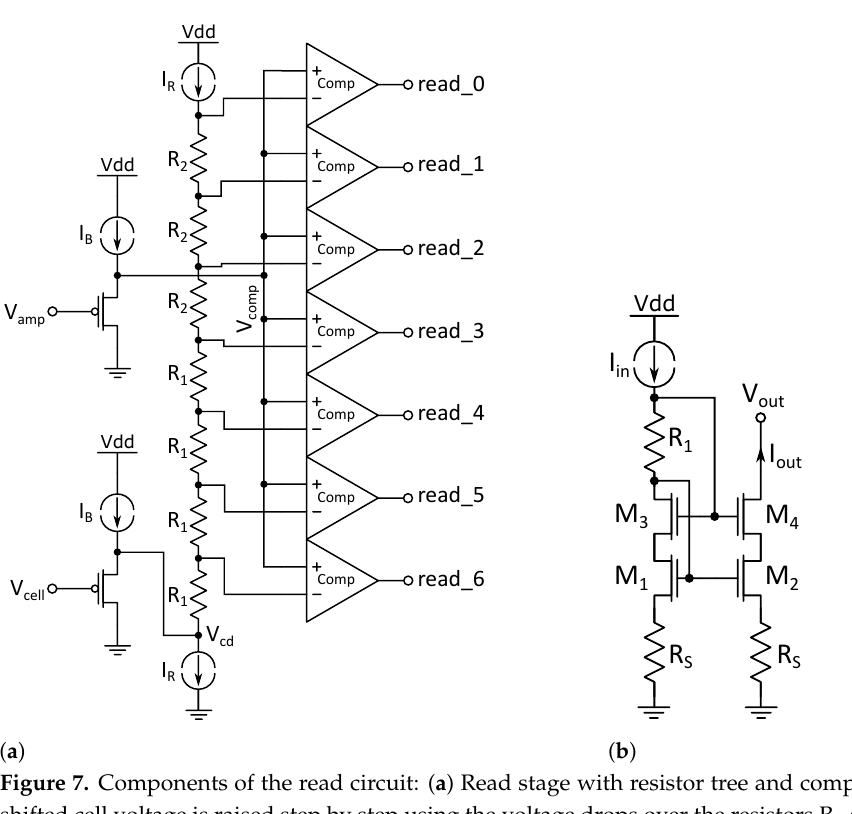
Figure 7. Components of the read circuit: ( a ) Read stage with resistor tree and comparators. The shifted cell voltage is raised step by step using the voltage drops over the resistors R 1 and R 2 in the resistor tree and compared with the shifted voltage from the output of the amplifier. ( b ) Precision current mirror used for I R in Figure